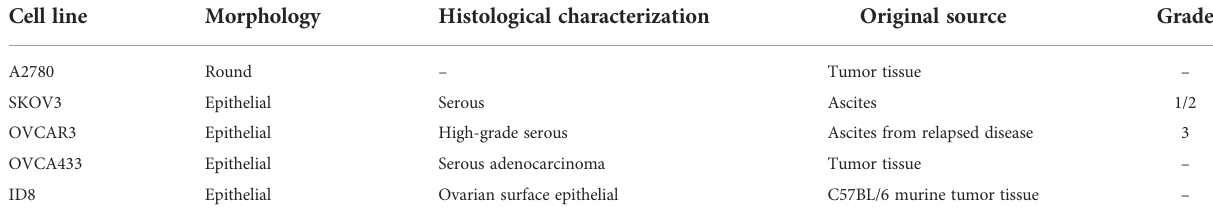
TABLE 2 Characteristics of ovarian cancer cell lines frequently used for various studies discussed here. Cell